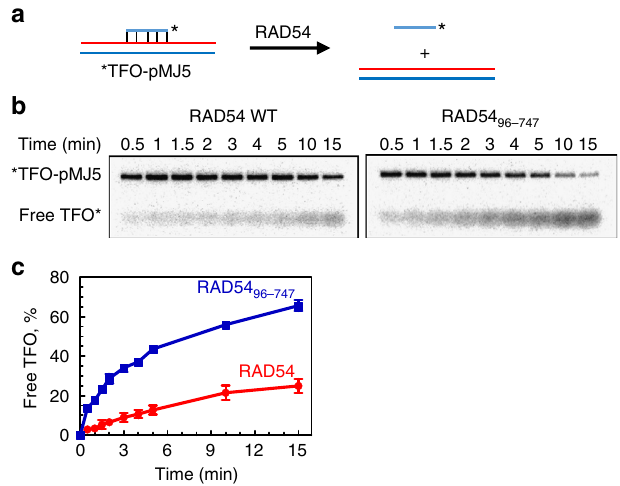
Fig. 3 The 95 a.a. N-terminal truncation enhances DNA translocation activity of RAD54. a The experimental scheme of the triple-helix displacement assay. The triple-helix forming oligonucleotide (TFO) is paired to the linearized pMJ5 plasmid. The asterisk indicates the 32 P-label. b The kinetics of triple-helix (0.5 nM, molecules) displacement by RAD54 (5 nM) or RAD54 96 – 747 (5 nM) was analyzed by electrophoresis in 1.2 % agarose gels. c Data from b are plotted as a graph. The values obtained in protein-free reaction (Supplementary Figure 1b) were subtracted from the values of RAD54-promoted reactions. Each experiment was repeated three times. Error bars represent the